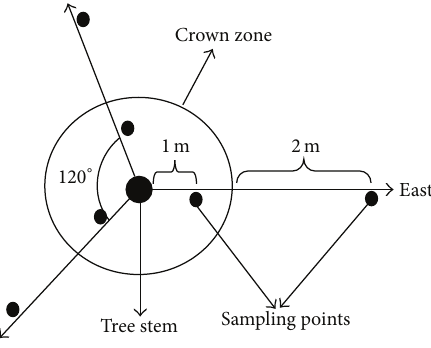
Figure 1: Diagram of the sampling design. Table 1: The sizes of the individual trees that were used in the study for